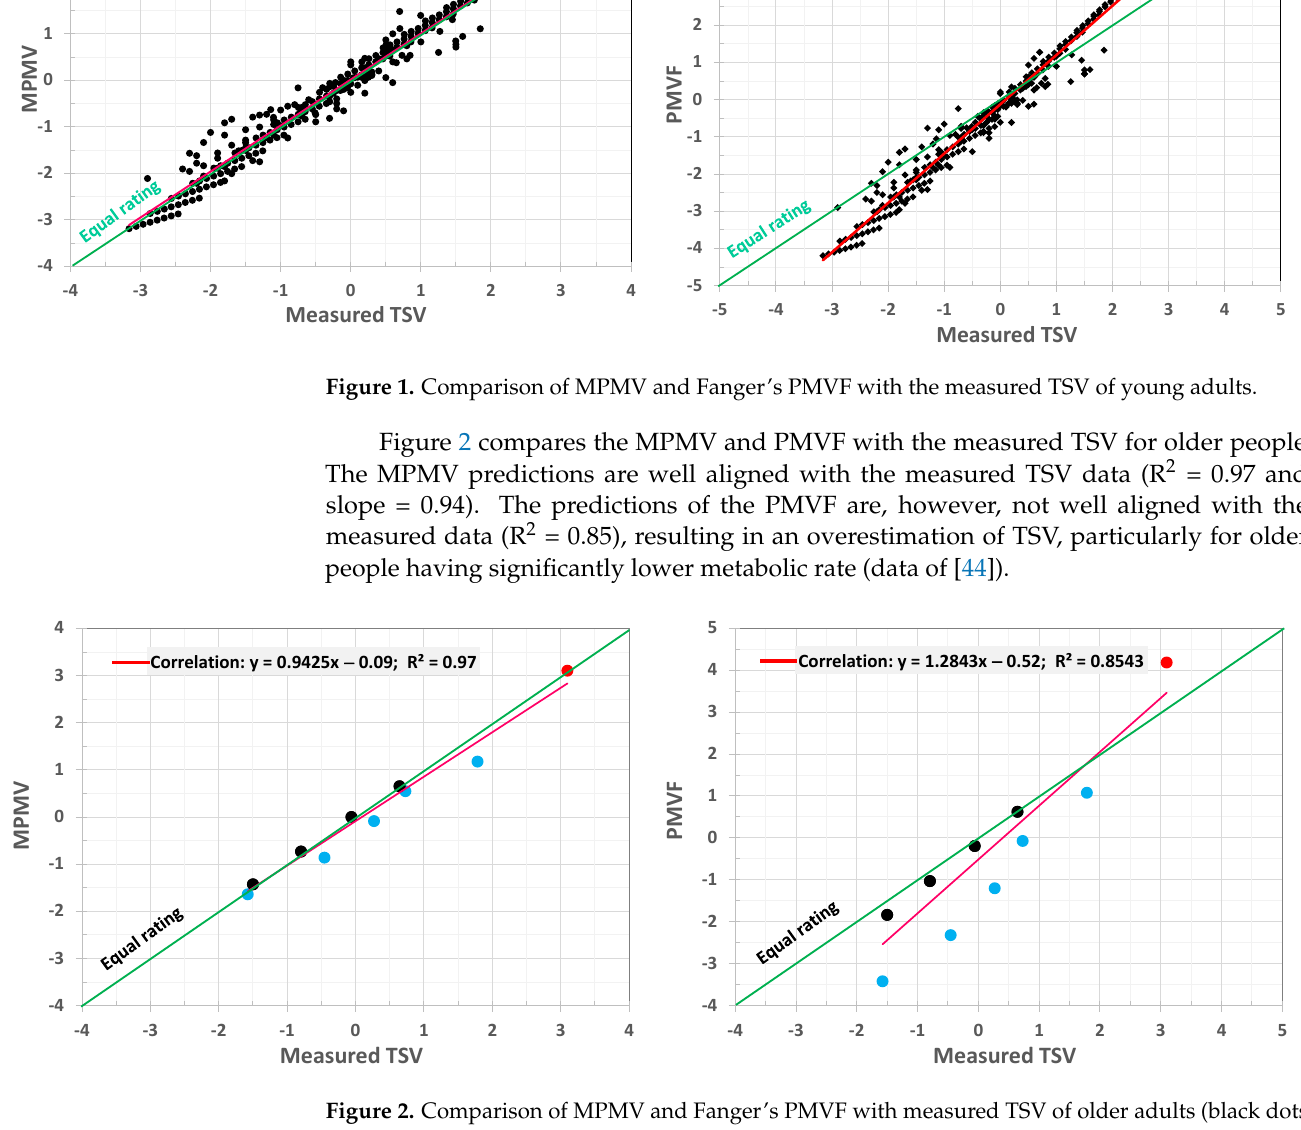
Figure 2. Comparison of MPMV and Fanger’s PMVF with measured TSV of older adults (black dots for [4], blue dots for [44], and red dot for [54]).